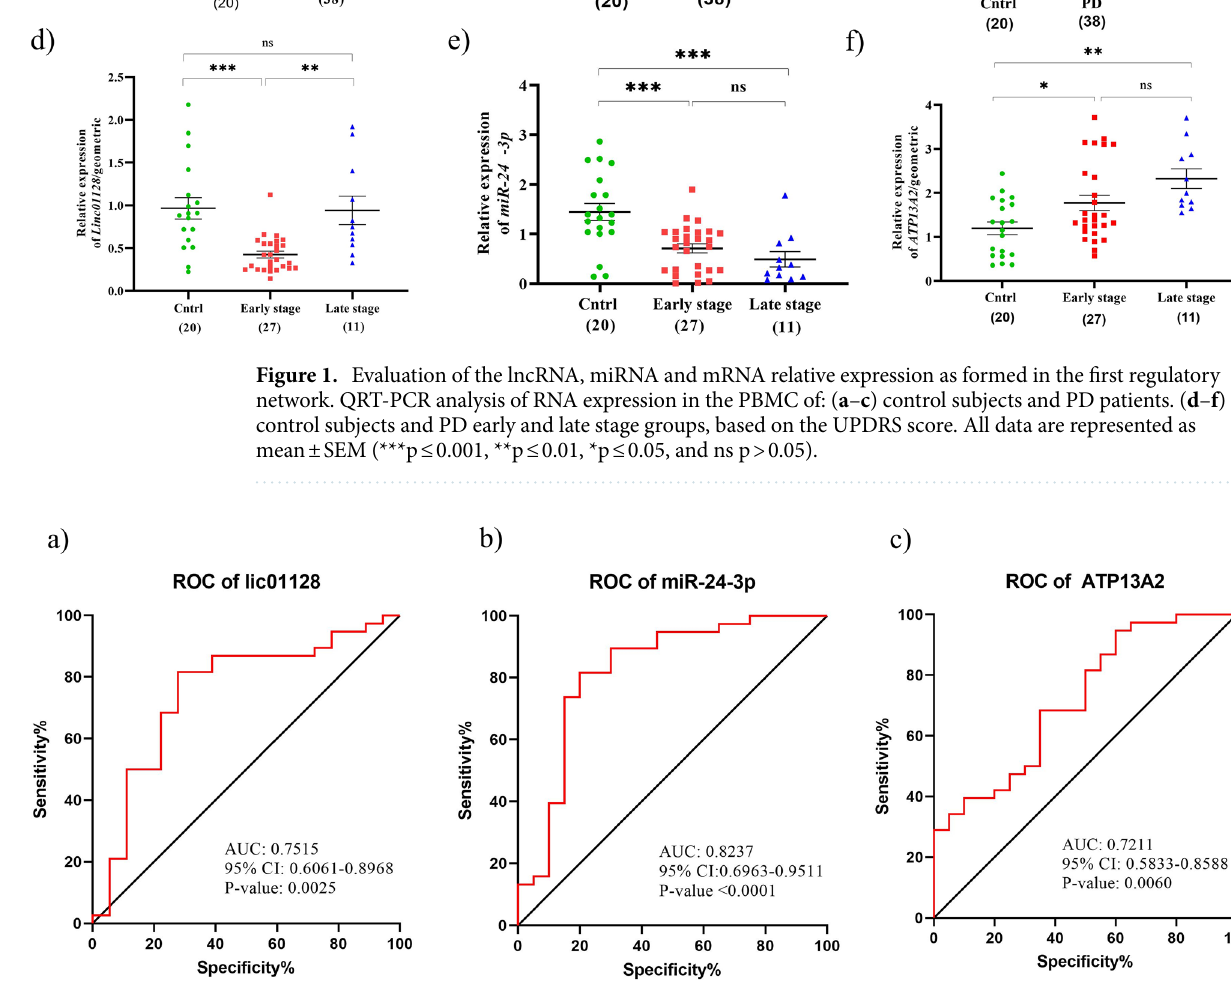
Figure 2. Analysis of the ROC curve for: ( a – c ) linc01128, miR-24-3p and ATP13A2 in the PD patients, as compared to the healthy